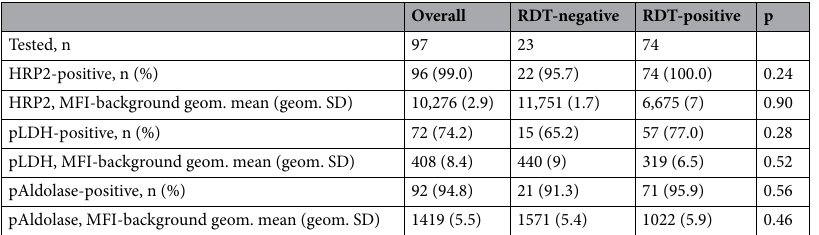
Overall RDT-negative RDT-positive p Tested, n 97